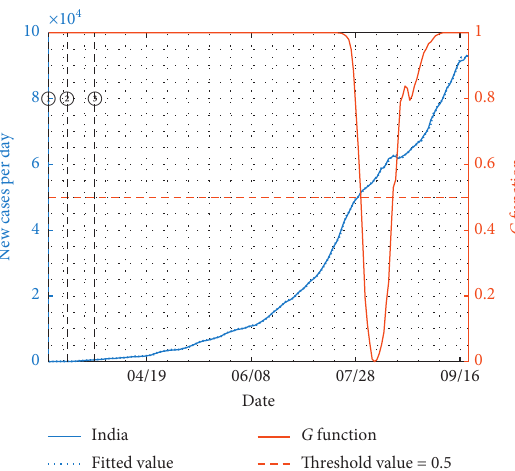
Figure 17: The fitting result of Mexico. The left axis shows the daily confirmed cases for the real data after smoothness (blue solid line) and its fitted values by the STAR model (blue dashed line). The right axis shows the value of nonlinear functions G changing with time (orange solid line) and the reference line with threshold 0.5 (orange dashed line). The vertical dotted line indicates the se- quential released policies: ① declare the public health emergency and suspend nonessential activities until April 30.